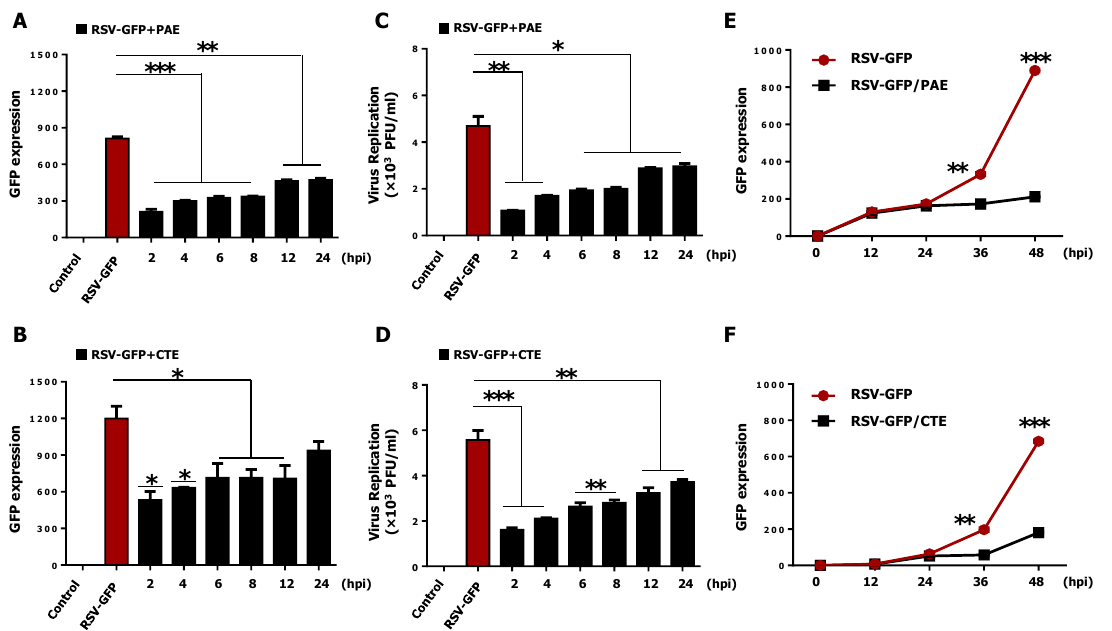
Figure 2. The therapeutic e ff ect of PAE and CTE against RSV-GFP infection. HEp2 cells were seeded into 12 well cell culture plates and left for 12 h. Medium was changed with DMEM containing 1% FBS and cells were infected with RSV-GFP (0.1MOI) for 2 h. ( A , B ) RSV-GFP infected cells were treated with 50 µ g / mL PAE or CTE at di ff erent times after post infection as indicated or left untreated, and GFP expression level was measured at 48 hpi. ( C , D ) Virus titer was measured from both supernatant and cells by standard plaque assay at 48 hpi and expressed as PFU. ( E , F ) Cells were treated with 50 µ g / mL PAE or CTE, and GFP expression level was measured at di ff erent time after virus infection as indicated. GFP absorbance and virus titer expressed as mean ± SD. Error bars indicate the range of values obtained from counting duplicate in three independent experiments (* p < 0.05, ** p < 0.01 and *** p < 0.001 regarded as significant di ff